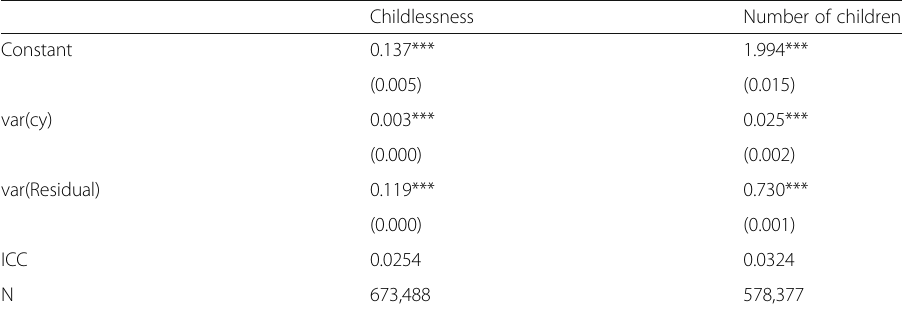
Table 1 Null multilevel regressions on childlessness (left table) and number of children (right table)